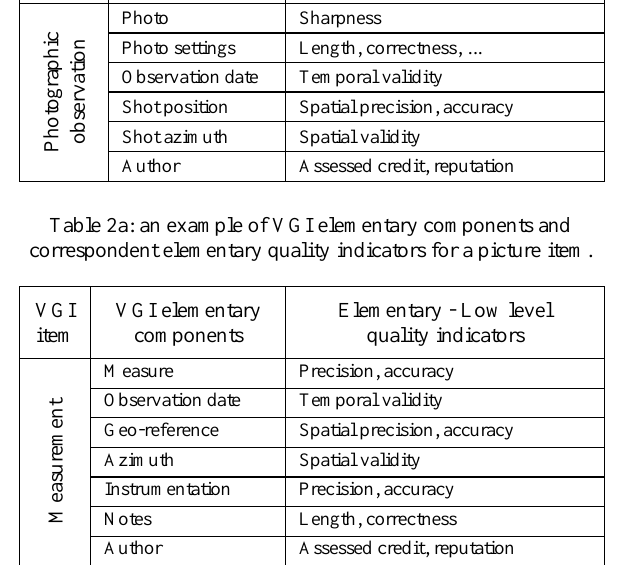
Table 2b: an example of VGI elementary components and correspondent elementary quality indicators for a measurement